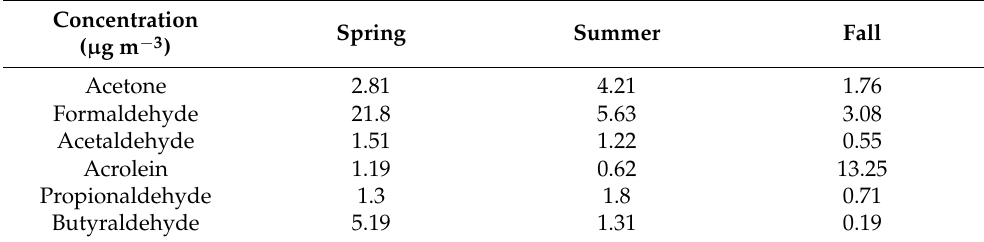
Table 7. The indoor/outdoor (I/E) concentration ratios of the carbonyl